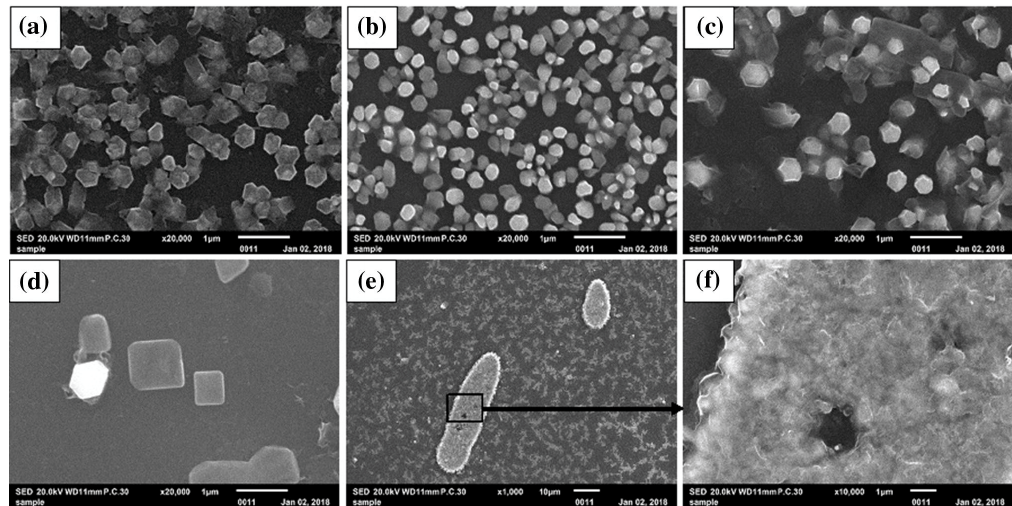
Figure 7. Surface images of undoped and doped ZnO films, ( a ) undoped, ( b ) 5% Al doping, ( c ) 10% Al doping, ( d ) 25% Al doping, ( e ) 50% Al doping, and ( f ) zoomed-in image of the zone indicated by the black rectangular box depicted in ( e ). Reproduced with permission from ref. [65].